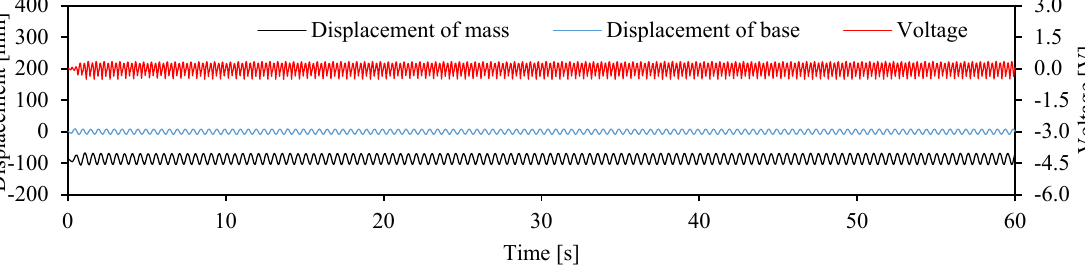
the mass block was smaller than that at a lower excitation frequency, such as 1.0 Hz. The